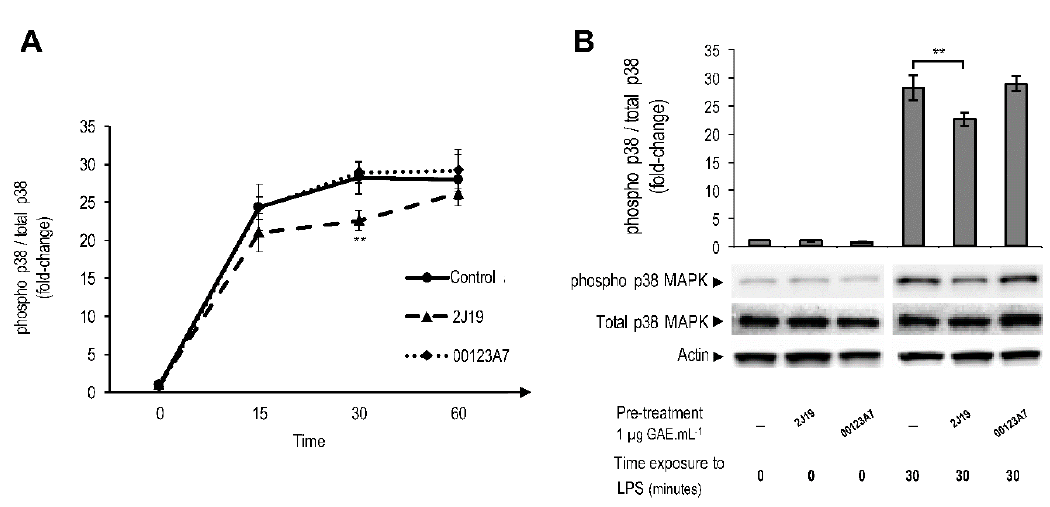
Figure 3. Modulation of MAPK p38 phosphorylation upon pre-treatment with 00123A7 and 2J19 GIB fractions. N9 microglial cells were pre-treated either with 2J19 or 00123A7 GIB fractions 6 h before LPS stimulation. ( A ) p38 phosphorylation (Thr180/Tyr182) ratio kinetics during 0, 15, 30, and 60 min of LPS stimulation. LPS-stimulated (control) cells are represented as ; cells treated with 2J19 prior to LPS stimulation are denoted as and cells treated with 00123A7 prior to LPS stimulation are denoted as . ( B ) Comparison of the p38 phosphorylation (Thr180/Tyr182) ratios between each type of pre-treatment at 0 and 30 min of LPS stimulation (mean ± SEM; n = 3). Statistical differences between 2J19 pre-treated cells and the LPS-stimulated control cells are denoted as ** p < 0.01.